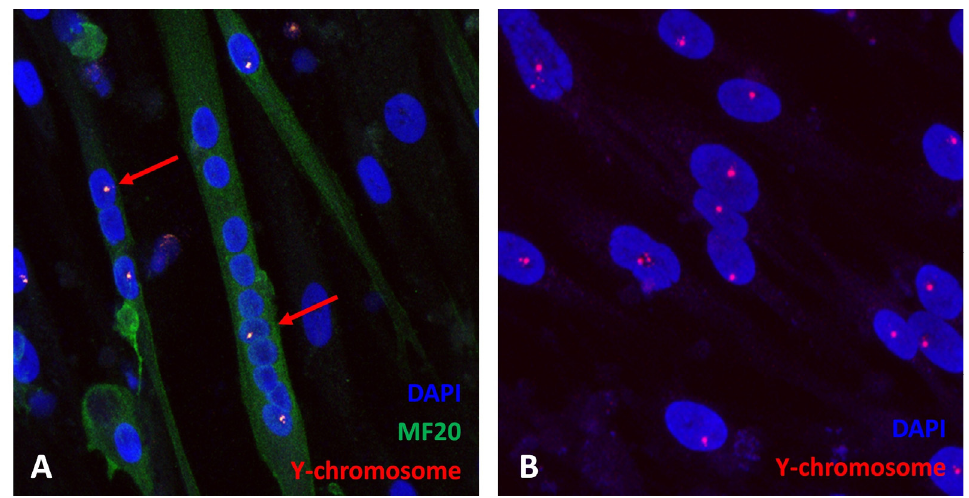
Figure 1. FISH Y-chromosome probe (red), MF20 staining (green), DAPI (blue). ( A ) Male mesoan- gioblast fusion with a female mesoangioblast and a female myotube (red arrow), ( B ) Y-chromosome FISH staining efficiency.